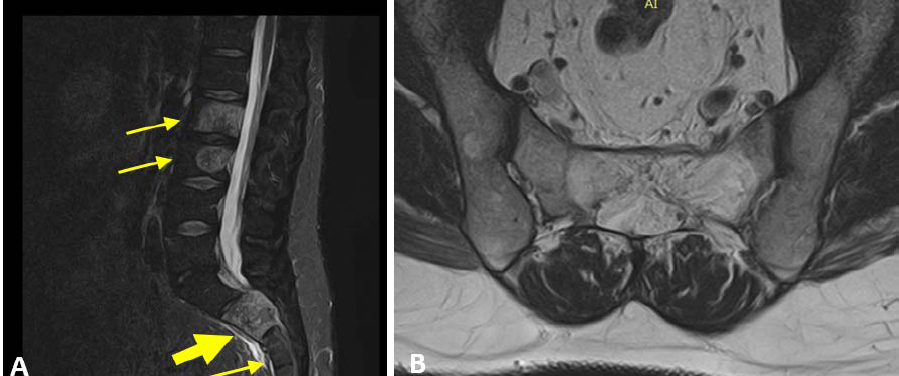
Figure 3. Multiple HAs were displayed in the lumbar and sacral vertebrae (little yellow arrows). S2 vertebral body (big yellow arrow) showed a wide HAs overcoming the cortex and occupying the medullary space (( A ), sagittal view; ( B ), transversal view).